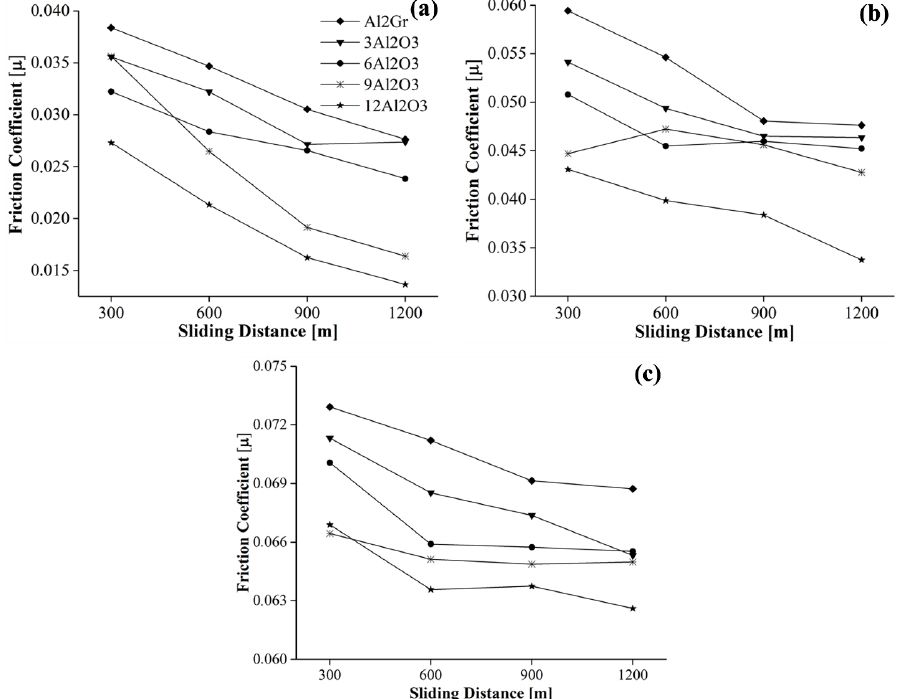
Figure 5: Friction coeflcients under different loads of composite materials with different amounts of Al 2 O 3 reinforced; 10 N (a), 20 N (b), and 30 N